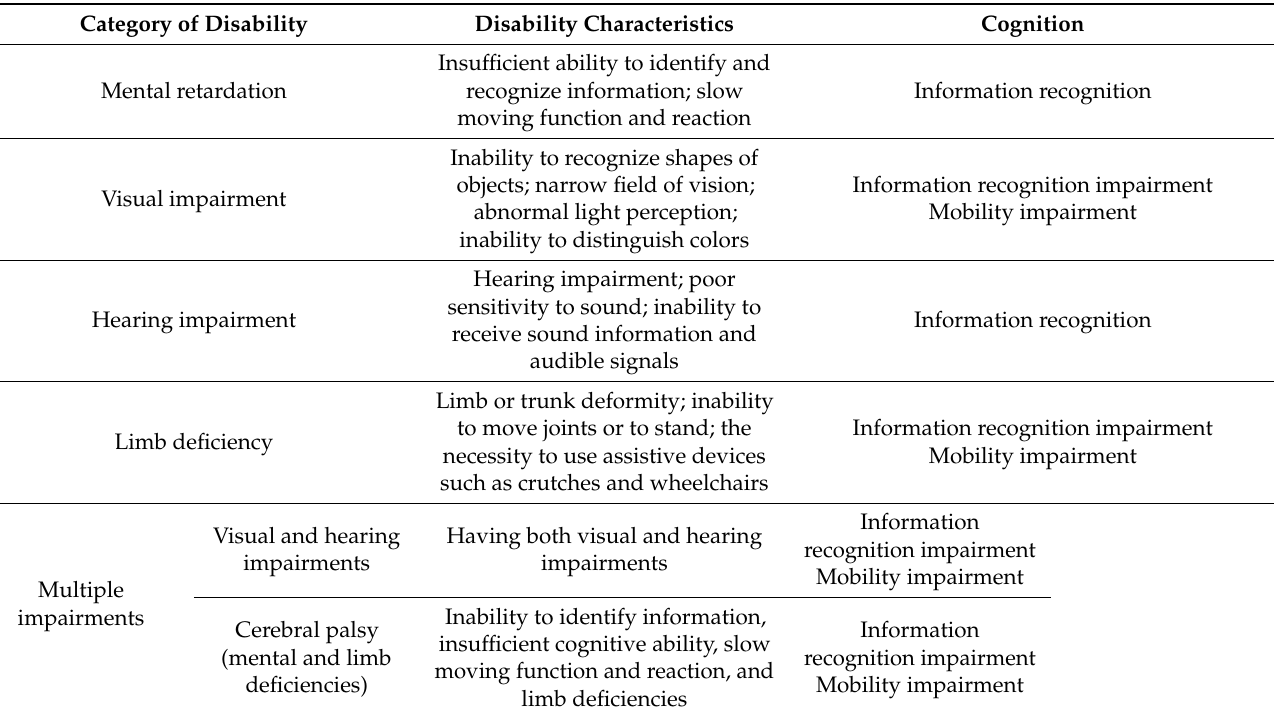
Table 1. Characteristics, cognition, and mobility of various disadvantaged groups during